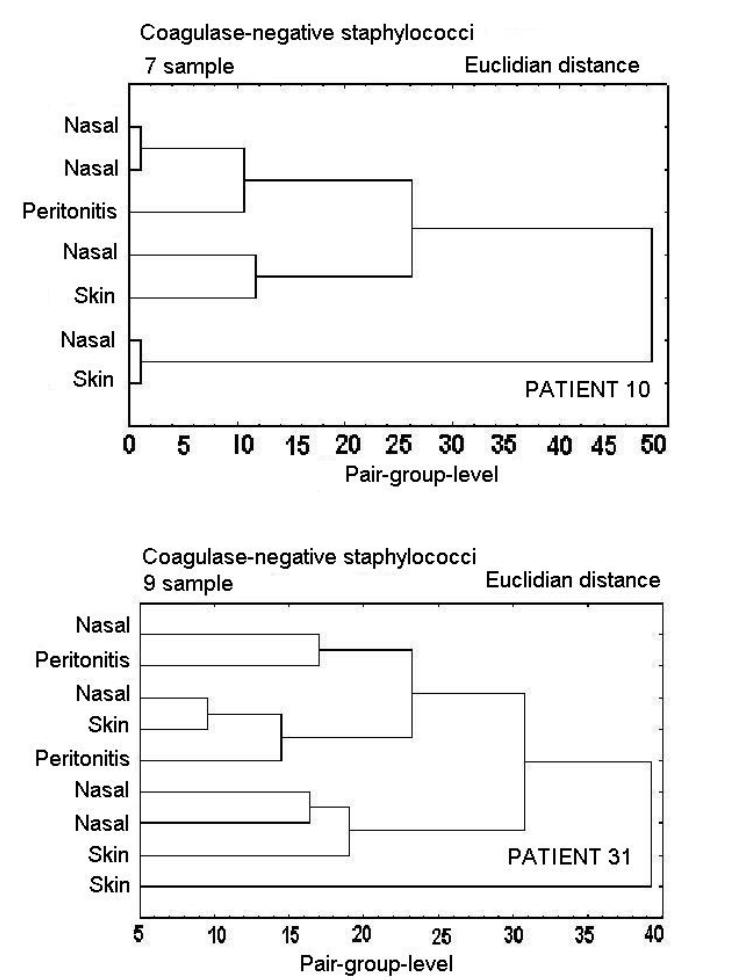
Figure 5: Similarity dendrograms drawn based on inhibition halos obtained by using the agar disk diffusion technique for coagulase-negative staphylococci isolated from the nasal cavity, pericatheter skin and peritoneal effluent of two patients undergoing peritoneal